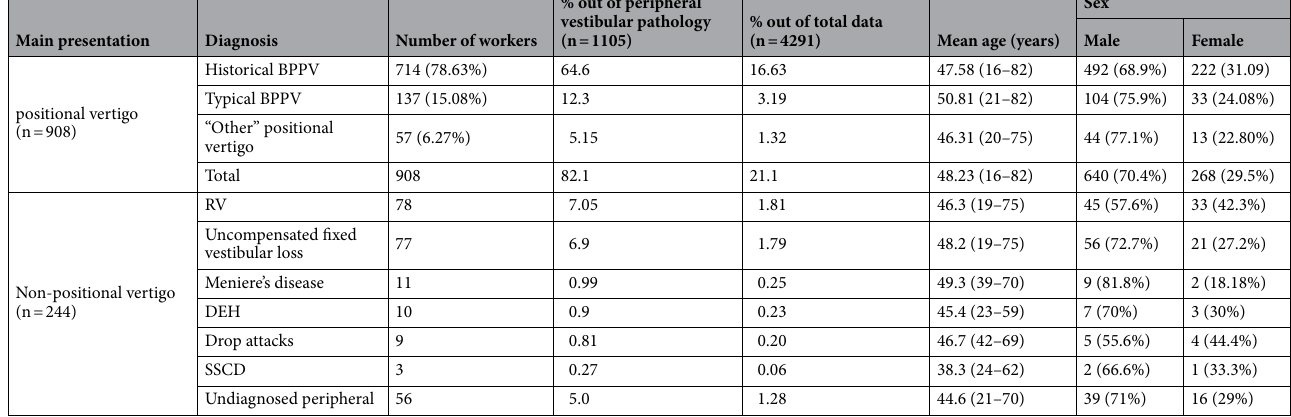
Table 1. Diagnosis of peripheral vestibular pathologies following head injury (n = 1105). BPPV benign paroxysmal positional vertigo, RV recurrent vestibulopathy, DEH delayed endolymphatic hydrops, SSCD superior semicircular canal